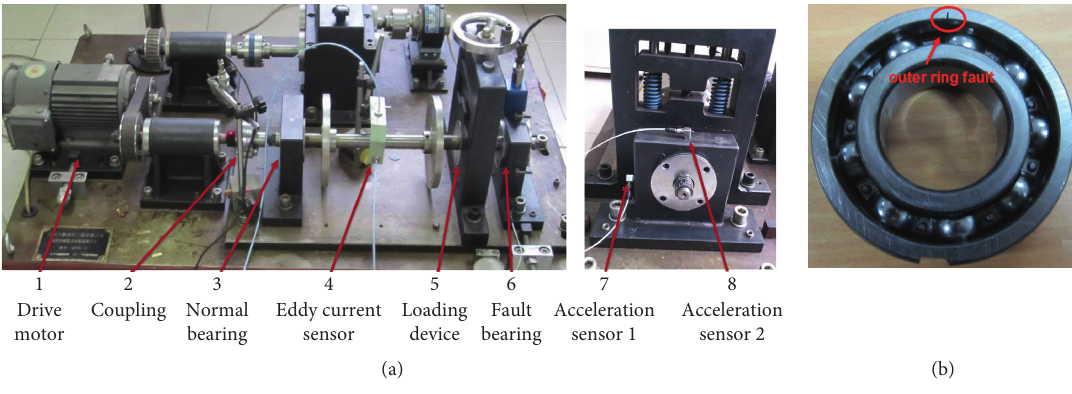
Figure 13: (a) Structure of the experimental platform; (b) bearing model of 6205E. Table 4: Structural parameters of the bearing.